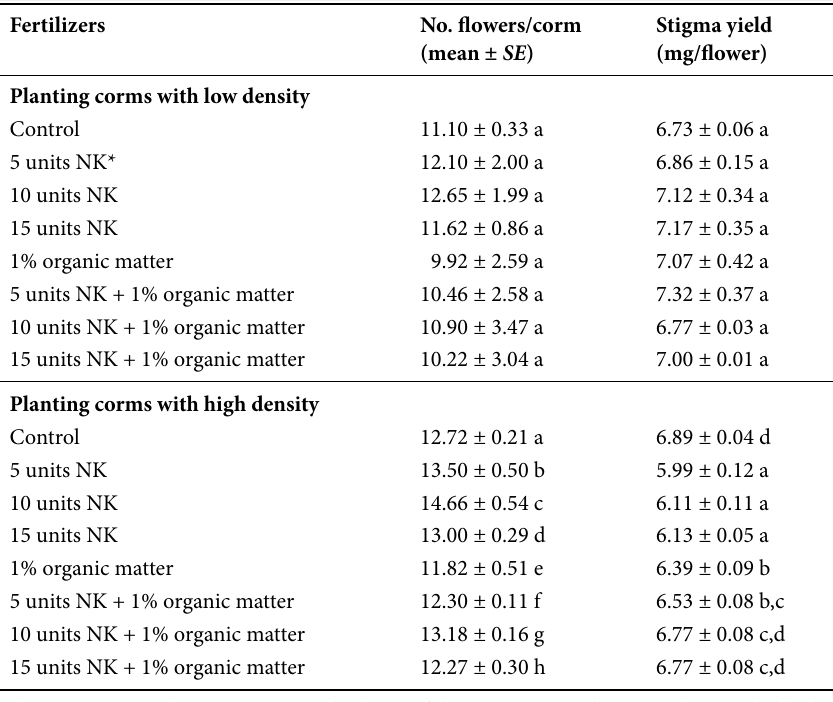
Table 2 Effect of different type of fertilization on number of flowers per corm and stigma